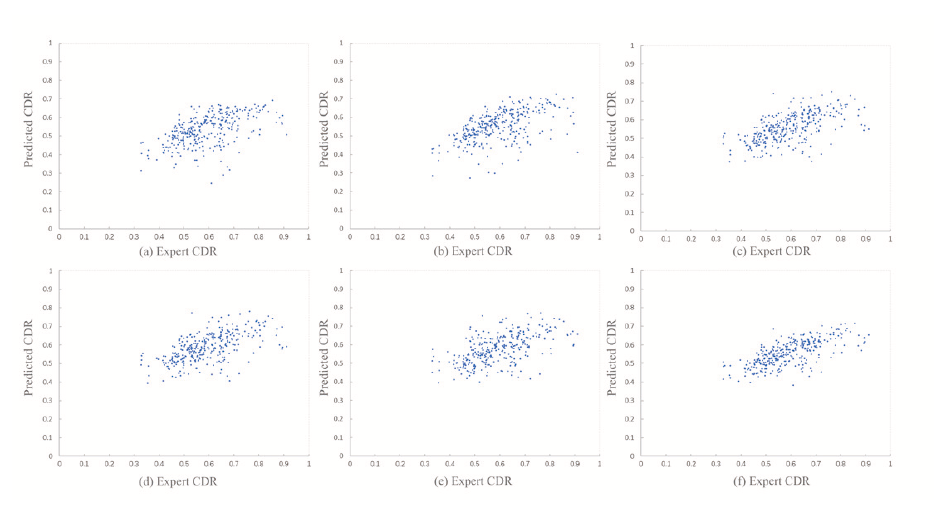
Figure 5. Comparison of Pearson’s correlation coefficient of different methods. ( a ) Baseline model. ( b ) Baseline model + SAB. ( c ) Baseline model + CAB. ( d ) Baseline model + CAB + SAB. ( e ) Baseline model + SAM. ( f ) Baseline model + CAB + SAB + SAM.